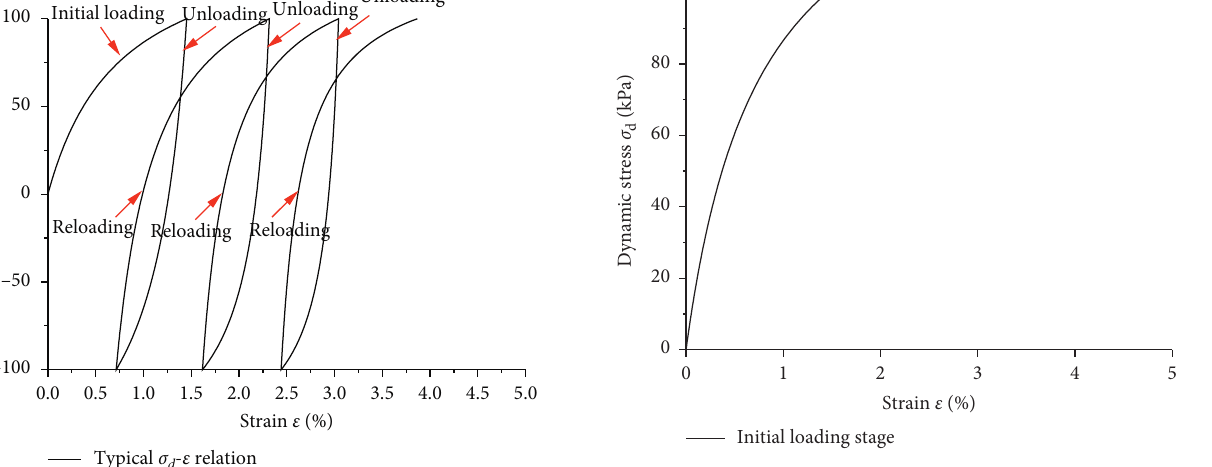
Figure 2: A typical stress-strain curve for the initial loading stage.